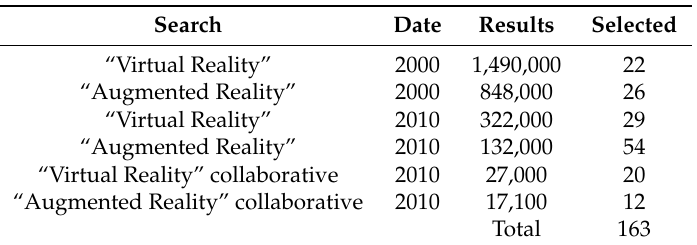
Table 1. Search process